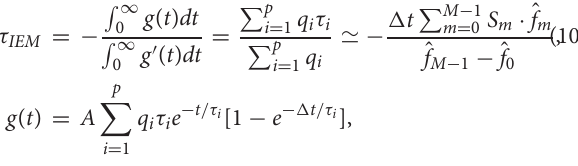
FIGURE 1 | Illustration of h m and irf m obtained with a TCSPC